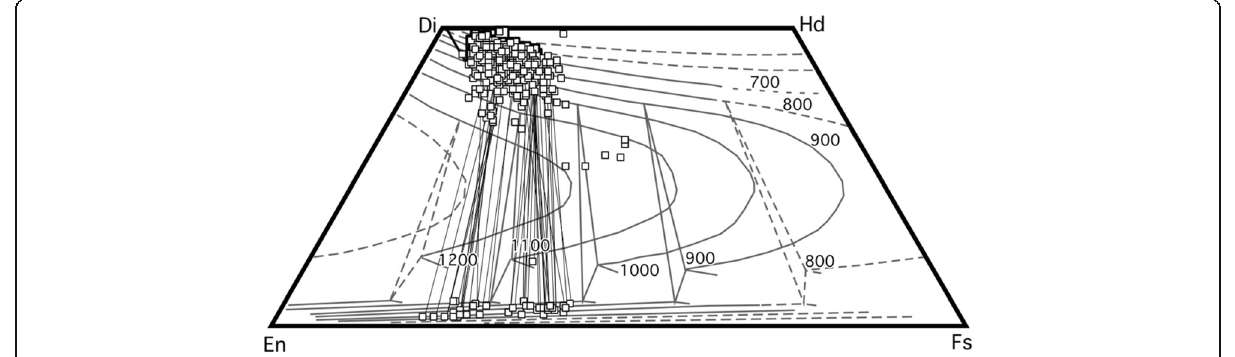
Fig. 12 Tetrahedral components of augite and hypersthene in Atlantis Bank gabbros calculated from Lindsley and Andersen (1983) and contoured for equilibrium temperatures for coexisting pyroxene pairs. The thin black lines are joins connecting coexisting mineral compositions. Temperature contours are in degrees centigrade, whereas dashed lines show inferred extensions of these contours. En, enstatite; Fs, ferrosilite; Di, diopside; Hd,